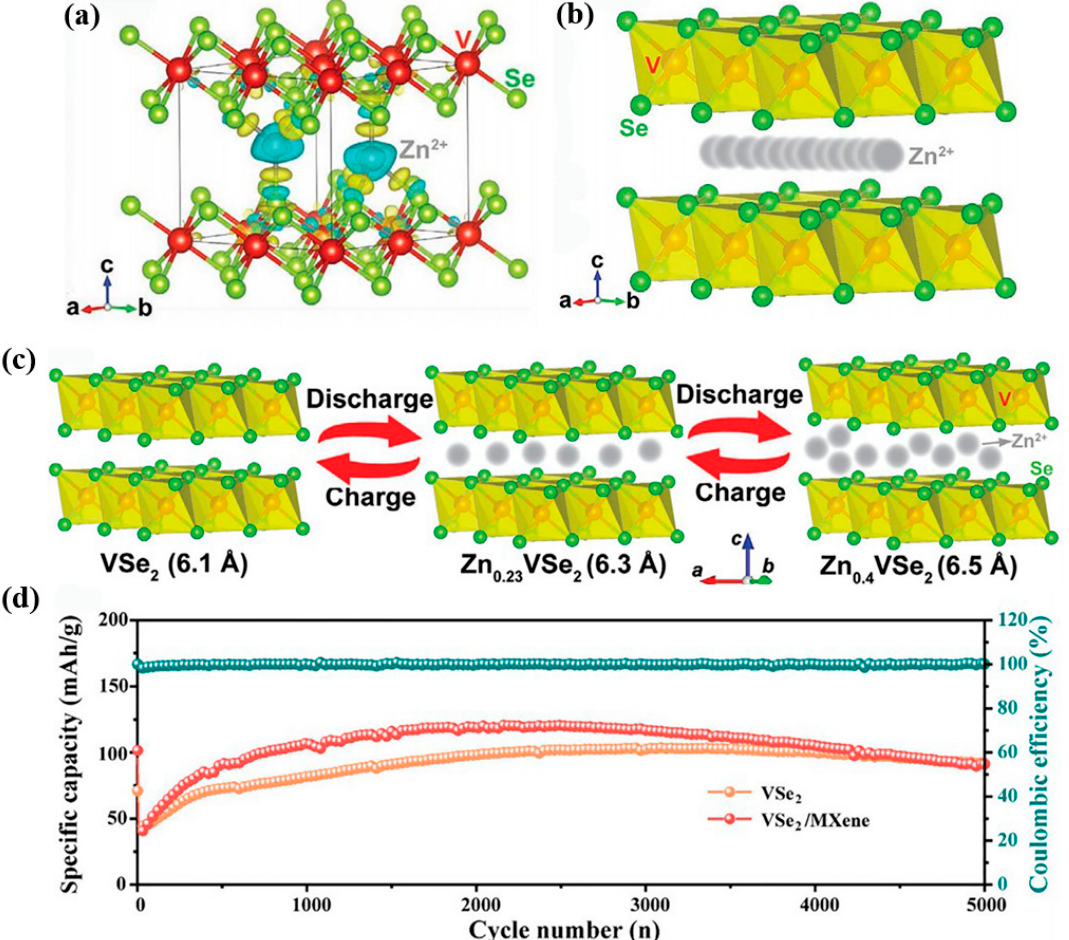
Figure 6. The kinetic process and cycle capability of a VSe 2 -based Zn battery. ( a ) The schematic of charge density map after zinc-ion intercalation. ( b ) The optimal diffusion pathway of zinc ions. ( c ) Schematic of the two-step Zn 2+ intercalation/de-intercalation process. Reproduced with permission [64]. Copyright 2020, Wiley-VCH GmbH. ( d ) Long-cycles performance at 5 A g − 1 . Reproduced with permission [65]. Copyright 2022, Elsevier Inc.